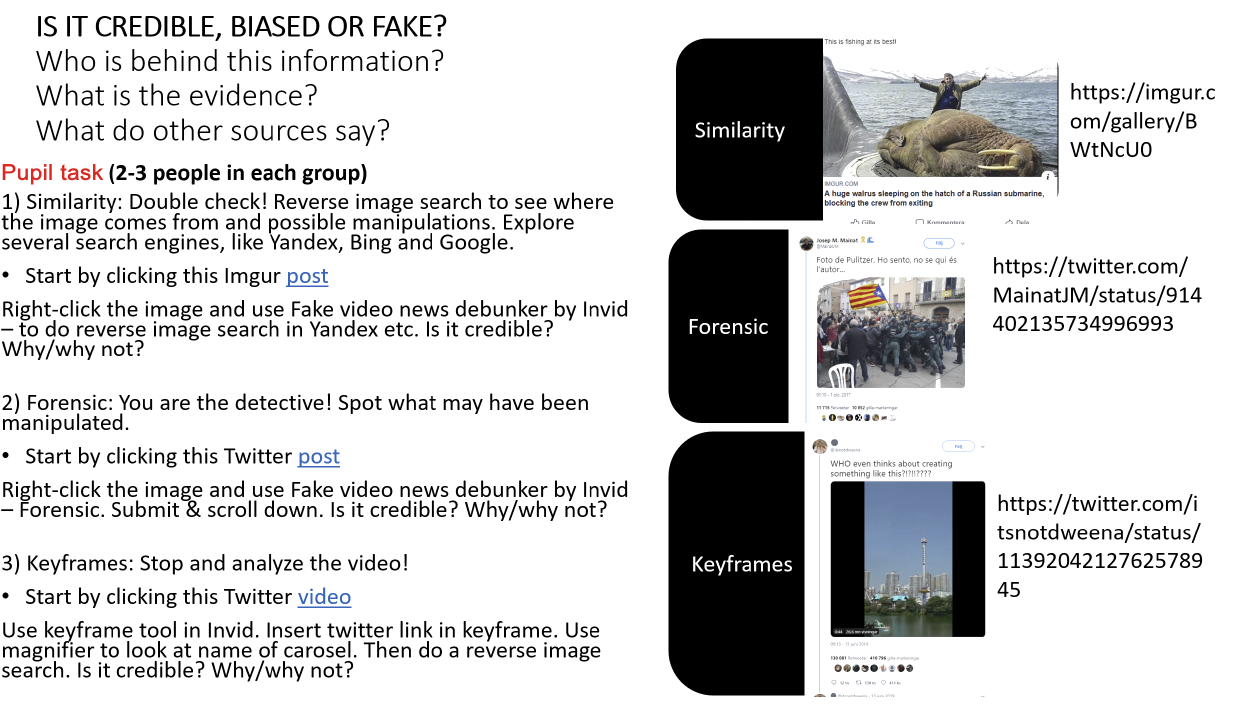
Figure 3. Pupils’ task designed to stimulate and scaffold their use of